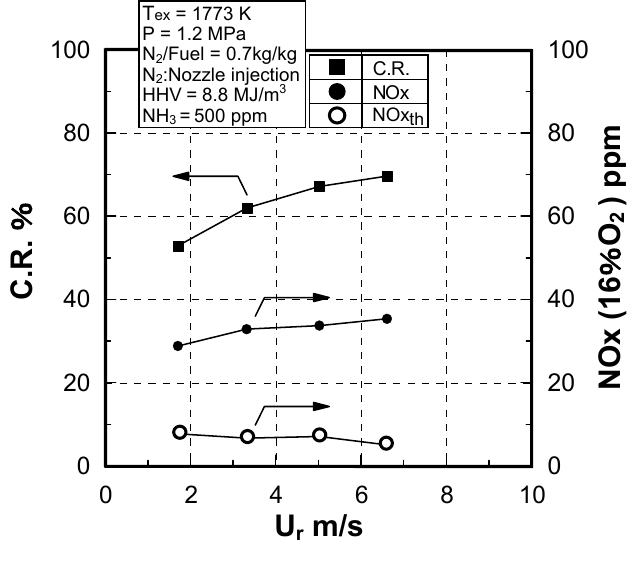
Figure 79. Effect of sectional flow velocity of air in combustor on NOx emission characteristics in case of nitrogen